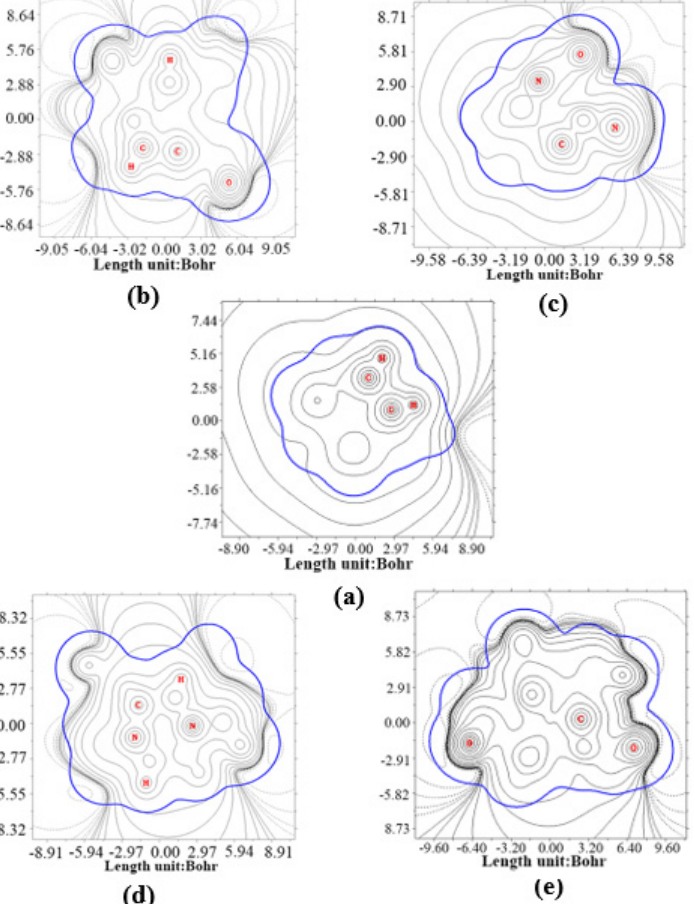
Figure 9. Contour map of electrostatic potential of CL-20 and it host–guest complex:( a ) CL-20, ( b ) CL-20/H 2 O 2 , ( c ) CL-20/CO 2 , ( d ) CL-20/N 2 O, and ( e ) CL-20/H 2 O. The bold blue line corresponds to the vdW surface (isosurface of electron density = 0.001 a.u., as defined by R. F. W. Bader). The solid and dashed lines represent the region having positive and negative values of ESP, respectively. The isovalues start at ± 0.001 a.u., and double at each step.